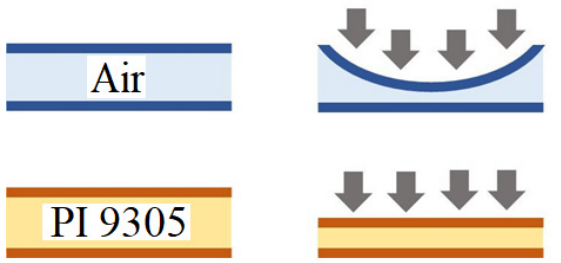
Figure 6. Dielectric layer deformation mode.